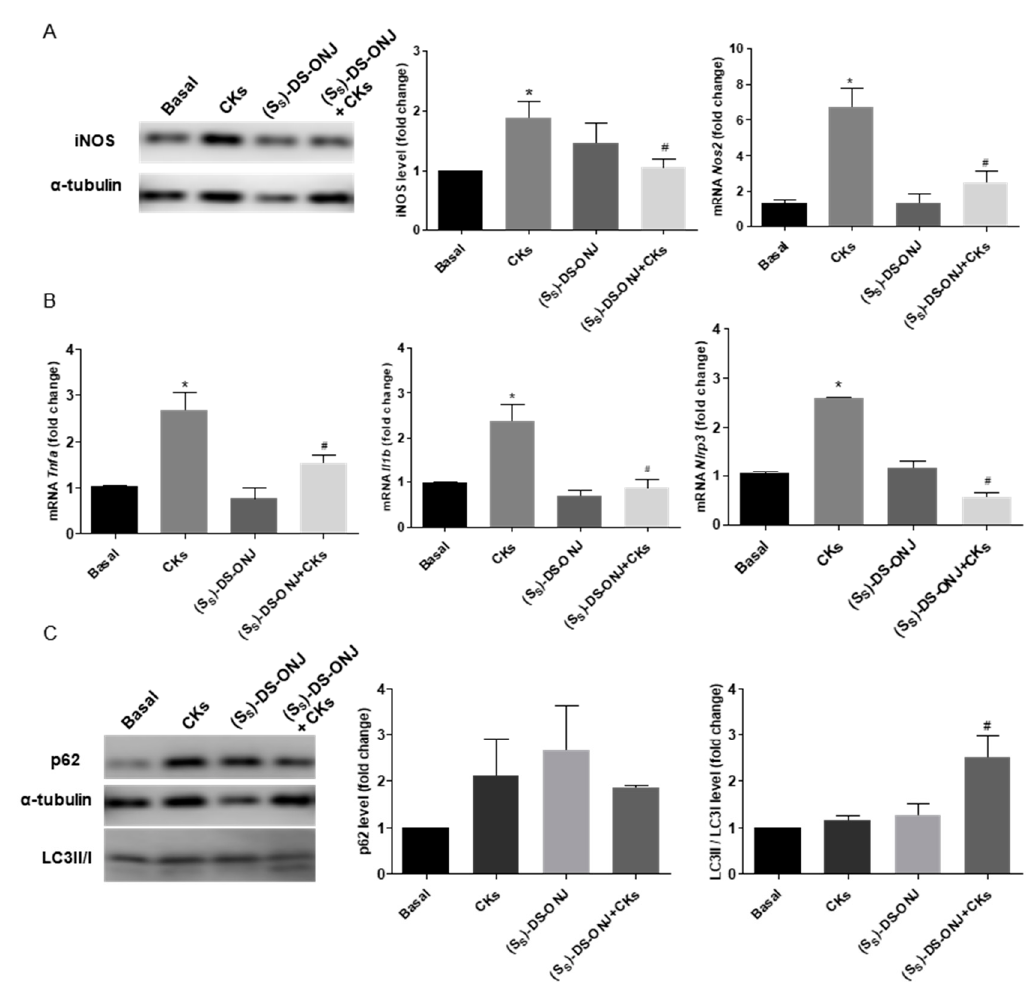
Figure 5. ( S S )-DS-ONJ inhibits the inflammatory events in CKs-stimulated AK explants from WT rats. ( A ) Protein extracts were analyzed by Western blot with the corresponding antibodies against iNOS and α -tubulin as a loading control (n = 6 AK explants per condition). mRNA levels of Nos2 were determined by qRT-PCR (n = 6 AK explants per condition). ( B ) mRNA levels of Tnfa , Il1b and Nlrp3 were determined by qRT-PCR and Actinb was used as housekeeping control (n = 6 AK explants per condition). ( C ) Protein extracts were analyzed by Western blot with antibodies against LC3II/I, p62 and α -tubulin as loading control of p62 (n = 6 AK explants per condition). The fold change relative to the basal condition is shown; * p ≤ 0.05 vs. Basal condition; # p ≤ 0.05 vs. CKs stimuli (two-way ANOVA followed by Bonferroni t